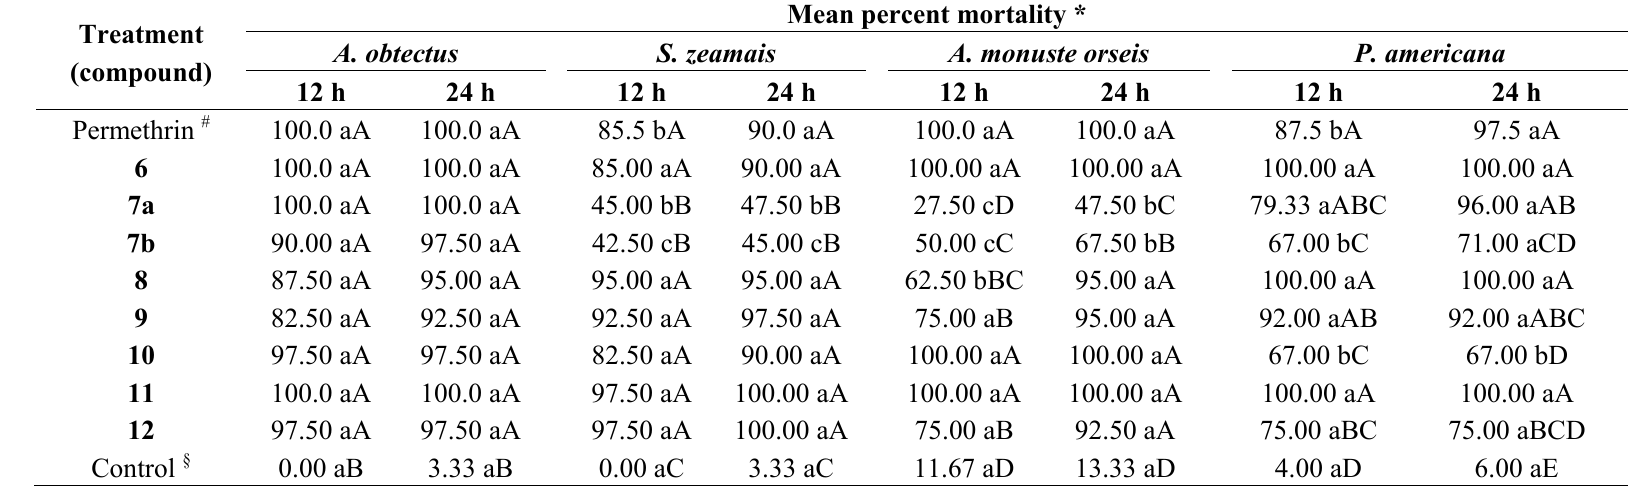
Table 2. Contact toxicity of the synthetic compounds at concentration of 5 μ g ( P. americana ), 10 µg ( A. monuste ) and 50 μ g ( A. obtectus and S. zeamais ) of compound per mg of